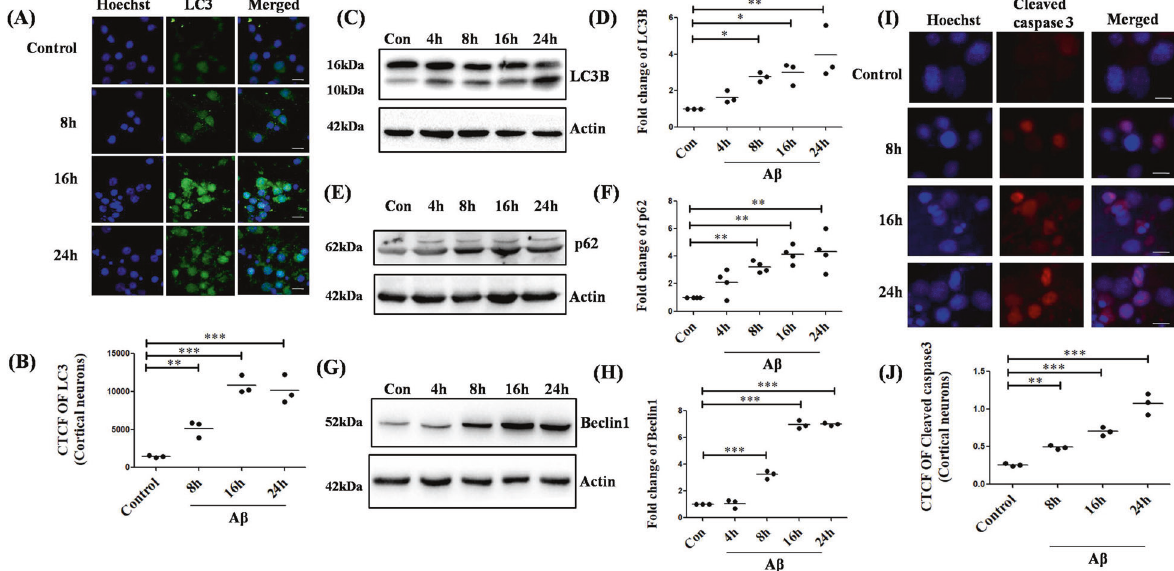
Fig. 2 A β evokes autophagy and apoptosis in primary cortical neurons. ( A ) Primary rat cortical neurons (7DIV) were treated with 1.5 µM A β for indicated time periods and stained with an anti-LC3B antibody (green) to assess the endogenous levels of the protein. Nuclei were stained using Hoechst (blue). Scale bars: 50 µm. ( B ) Graphical representation of the corrected total cell fl uorescence of LC3B. Data represented were collected from 3 independent experiments. Primary rat cortical neurons (7DIV) were treated with 1.5 µM A β for indicated time periods and the cell lysates were subjected to western blot analysis to check the levels of ( C ) LC3B, ( E ) p62, and ( G ) Beclin1 respectively. ( D ), ( F ) and ( H ) are the graphical representations of the fold change of the protein levels of LC3B, p62, and Beclin1 respectively. Data represented were collected from 3 independent experiments, except for ( F ) where data represented was from 4 independent experiments. ( I ) Primary rat cortical neurons (7DIV) were treated with 1.5 µM A β for indicated time periods and stained with an anti-cleaved caspase-3 antibody (red) to assess the endogenous levels of cleaved caspase-3. Nuclei were stained using Hoechst (blue). Scale bars: 50 µm. ( J ) Graphical representation of the corrected total cell fl uorescence of cleaved caspase-3. Data represented were collected from 3 independent experiments. The asterisks denote statistically signi fi cant differences from control at corresponding time points; * p < 0.05, ** p < 0.001, *** p <